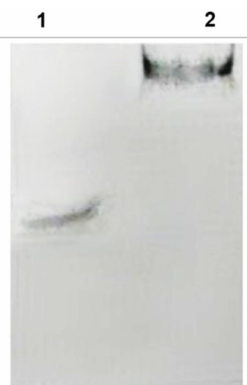
Figure 8. EMSA assay performed on FadE8 protein. A biotin-labeled DNA probe was incubated with the protein for 20 min at 25 ◦ C. Lane 1, DNA probe. Lane 2 DNA-probe incubated with 40 µ M FadE8 showing the retardation